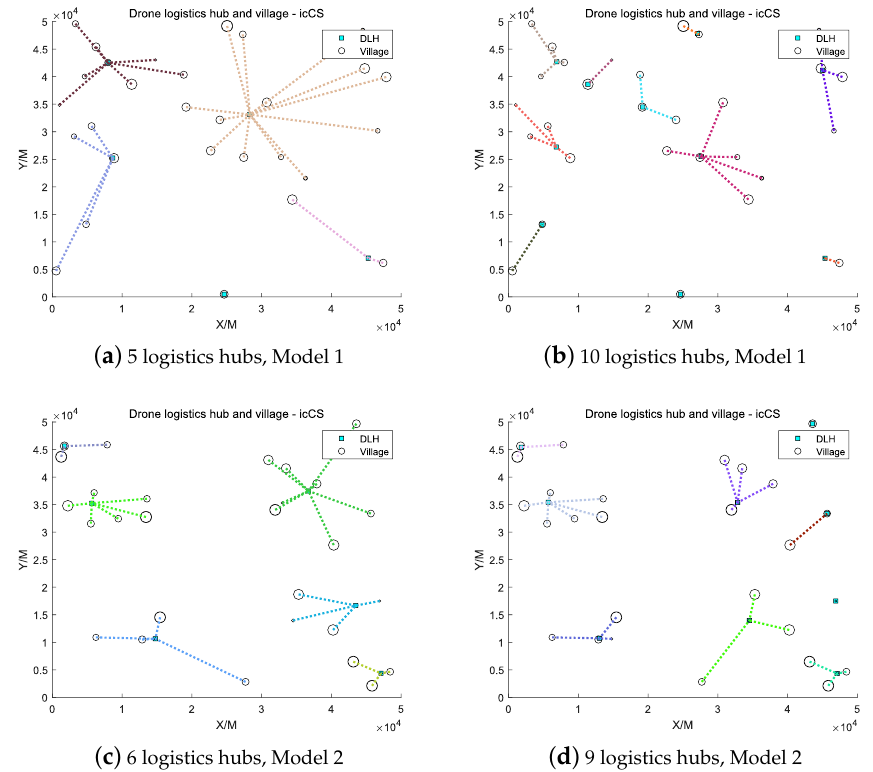
Figure 5. Execution results of drone logistics hub location problem under different models and different numbers of hubs: ( a ) five logistics hubs, Model 1; ( b ) ten logistics hubs, Model 1; ( c ) six logistics hubs, Model 2; and ( d ) nine logistics hubs, Model